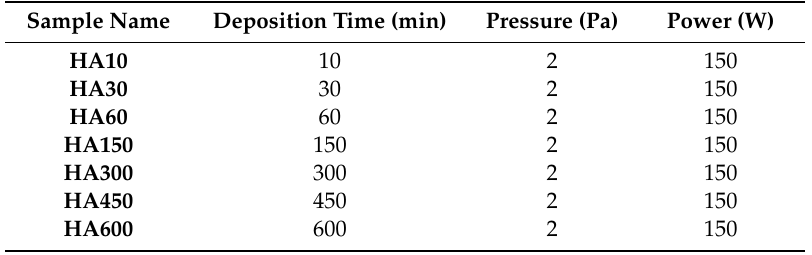
Table 1. Sputter deposition operational parameters and sample